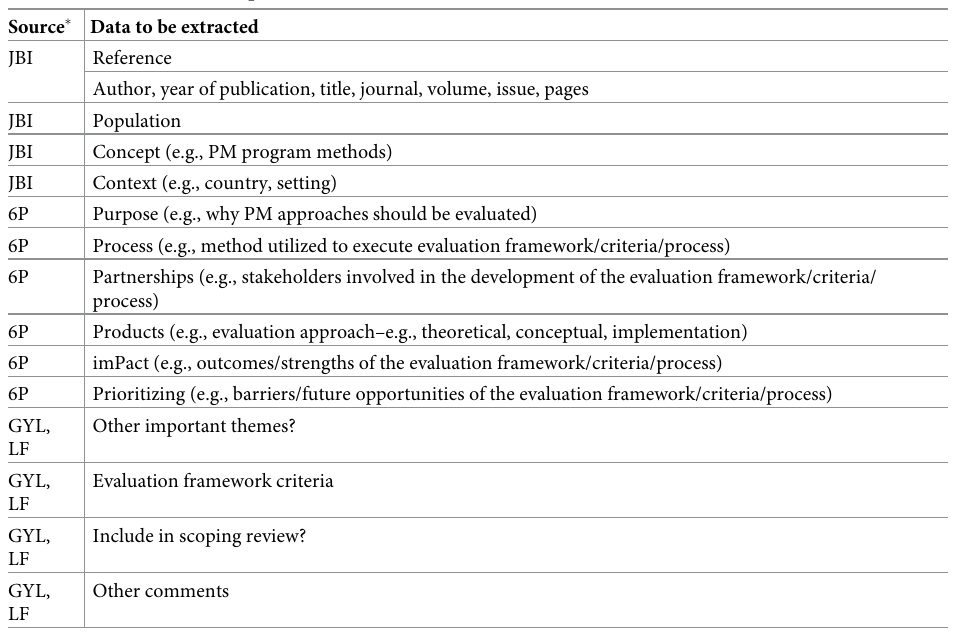
Table 3. Data extraction